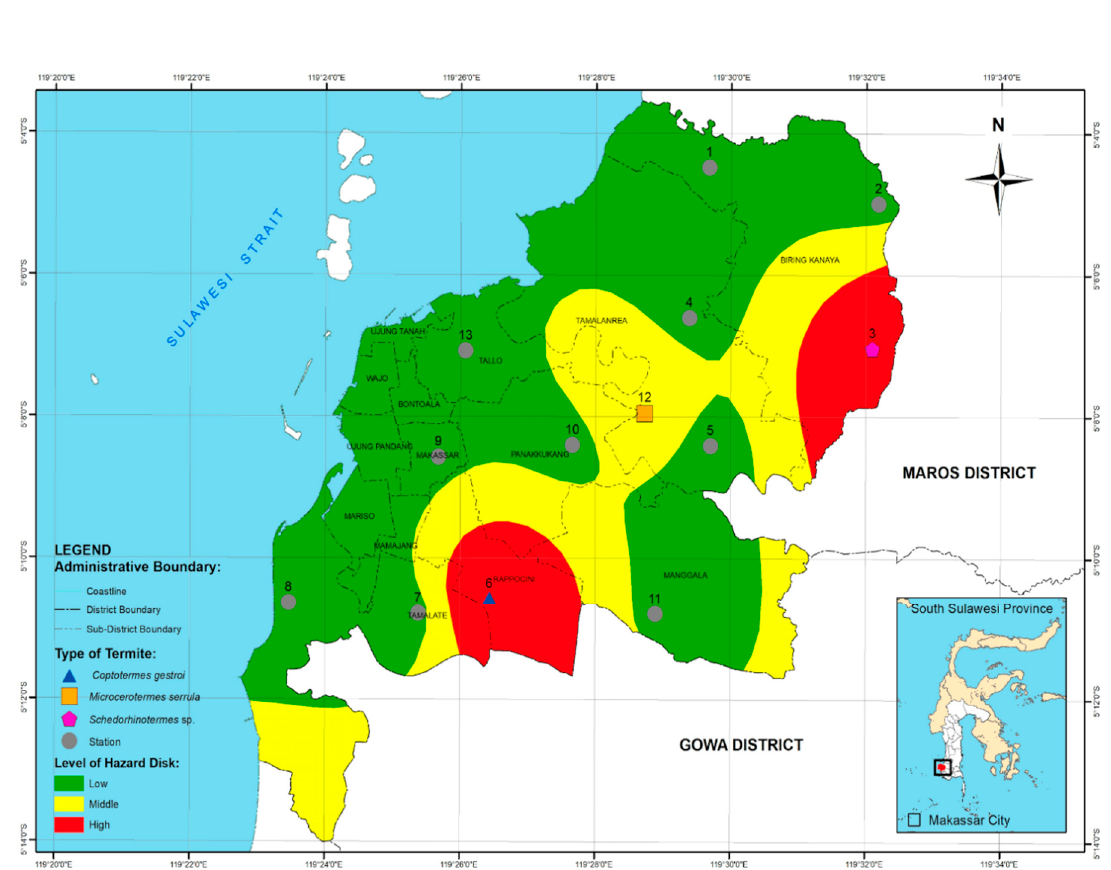
Figure 7. Map of hazard risk of subterranean termite attack in Makassar city, South Sulawesi province.